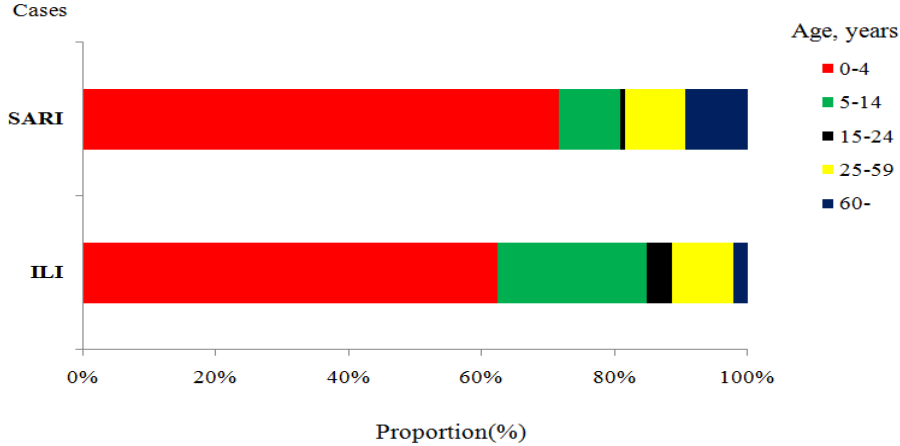
Figure 2. Age distribution among total reported ILI and SARI cases in Zhejiang Province, March Figure 2011–June 2015 (ILI = Influenza-like illness; SAIR = severe acute respiratory illness).